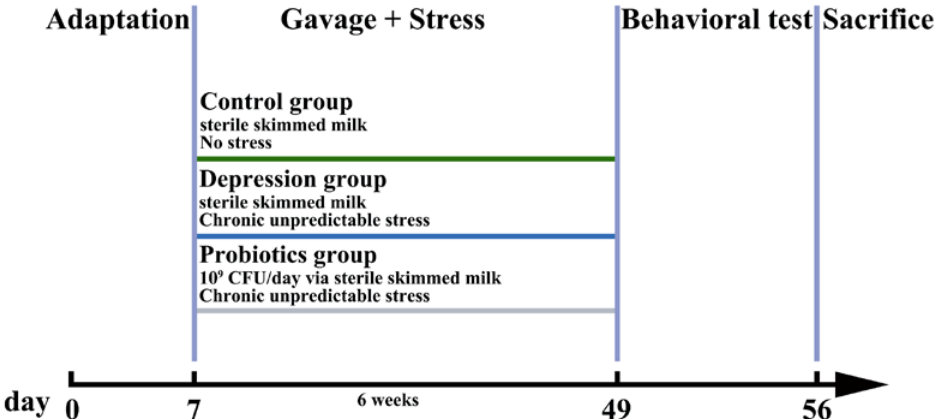
Figure 1. Animal experiment schedule. The whole experimental period was eight weeks, including one week of adaptation and six weeks of chronic stress. After the adaptation period, mice were gavaged until the day before mice were sacrificed. Behavioural tests were performed during the eighth week for all the mice.